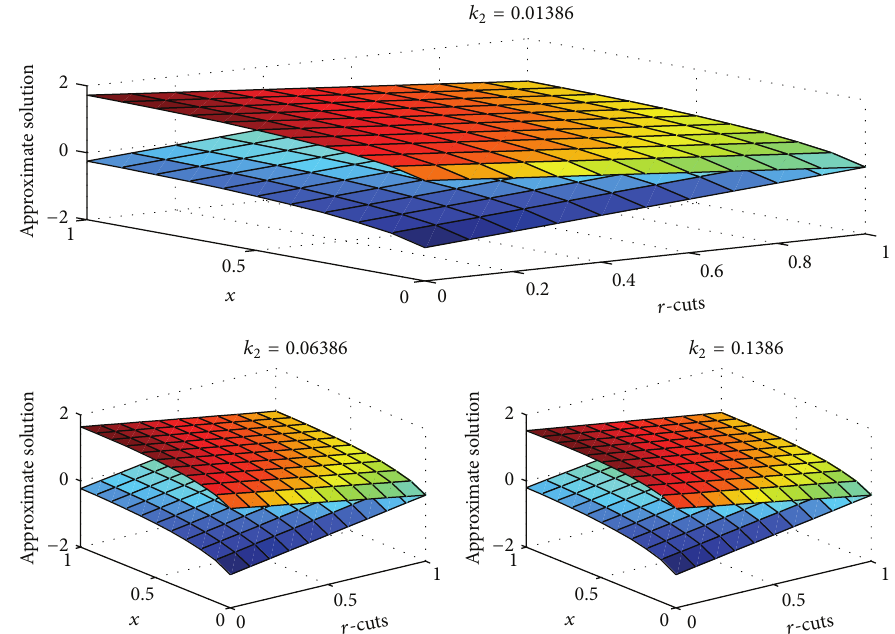
Figure 7: The fuzzy approximate solution of Case II, for different value of 𝑘 2 ,𝛼 = 0 , 𝛽 = 0.5 , and 𝑁 = 9